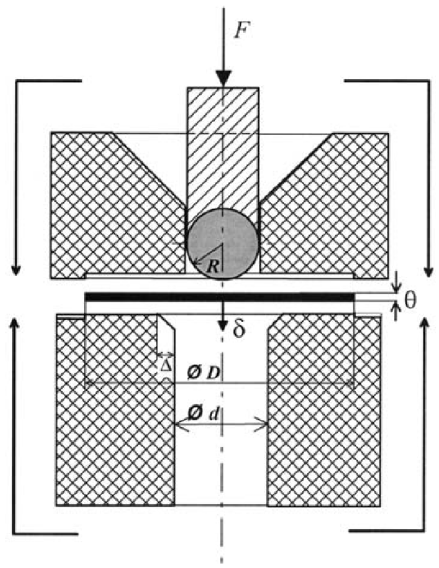
The cylinders were then hot extruded at 873 K with a 94 % reduction in cross-section into rods of 10 mm diameter. Due to the high affinity of aluminium to oxygen, the system also contained a small amount of Al 2 O 3 particles (ca. 1 vol.%).